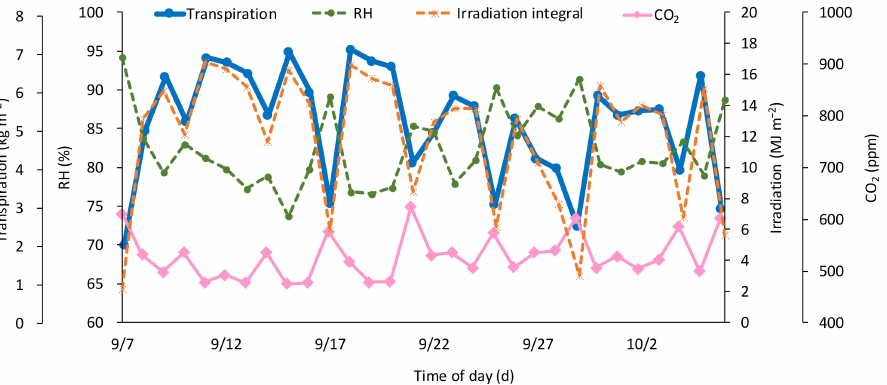
Figure 14. Transpiration (Equation (32)) calculated from 8:00 a.m. to 6:00 p.m. The higher the amount of irradiation, the more the stomatal pores open, whereas the higher the atmospheric humidity and CO 2 concentration, the more the stomatal pores closed because the humidity and CO 2 level inside the leaf had increased.